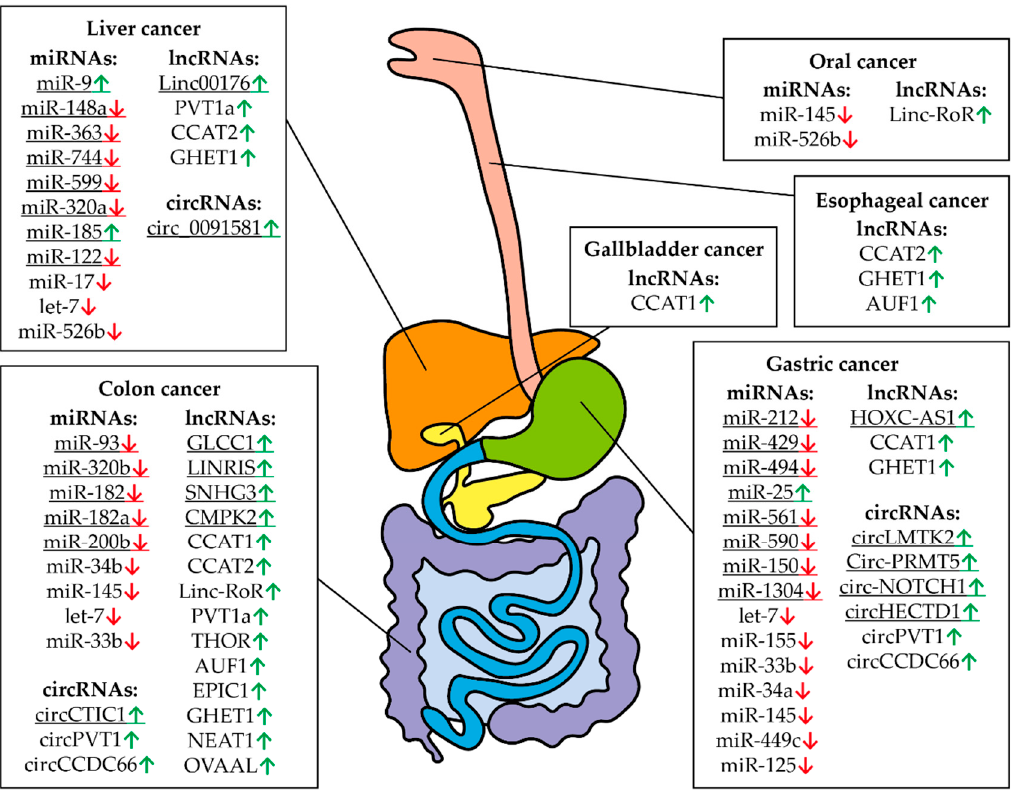
Figure 7. Controlling MYC RNAs in different types of digestive system cancers. The fields indicate miRNAs, lncRNAs, and circRNAs that have altered expression compared to healthy tissues in a particular cancer. Arrows indicate an increased (green) or decreased (red) level of RNA in a particular type of cancer. The digestive system is represented schematically. The underlined RNAs are currently believed to be tissue specific but new roles can potentially be discovered.